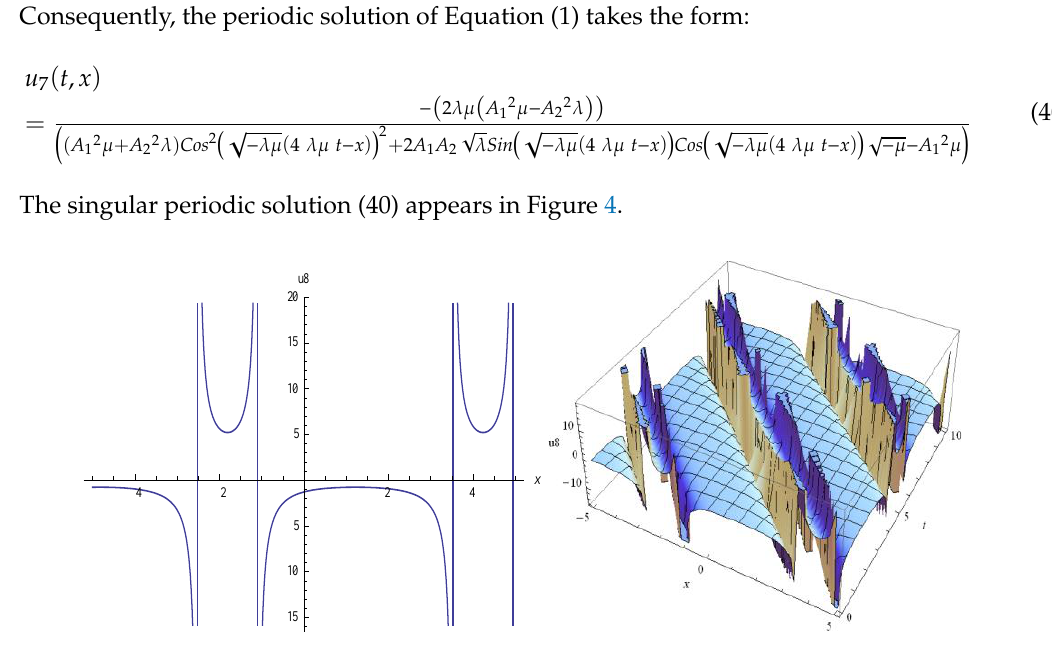
Figure 4. Singular periodic solutions (40) of Equation (1) and its projection at 𝑡 = 0 when 𝜇 = −0.3, 𝜆 = 0.9,𝐴 1 = 0.4, 𝐴 2 = 0.5 .